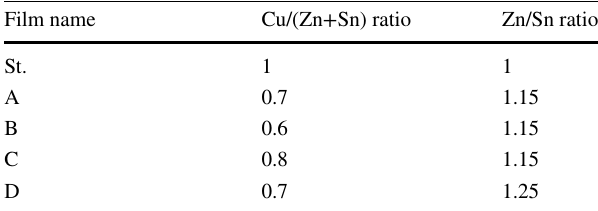
Table 1 Composition of the precursor solutions of the films deposited from single cationic